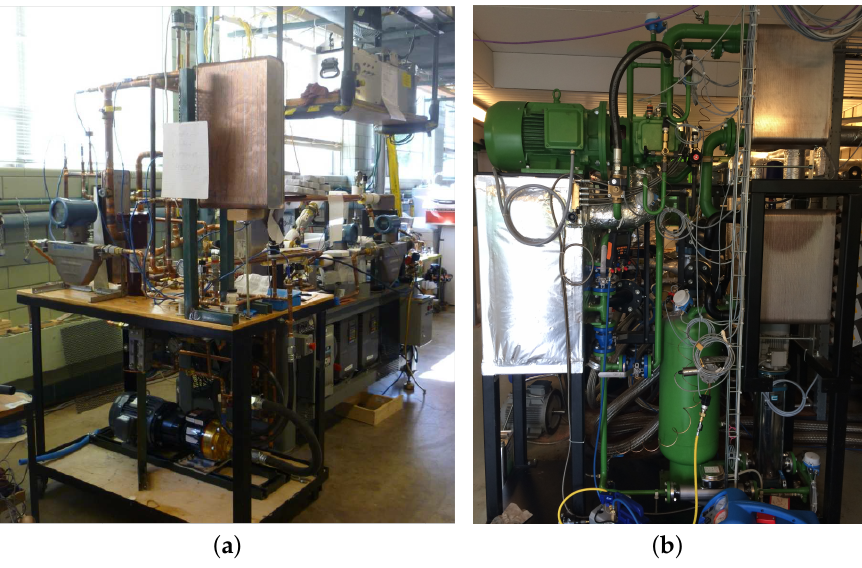
Figure 8. ( a ) Regenerative ORC with oil flooding loop at Ray W. Herrick Laboratories, Purdue University (PU); ( b ) regenerative ORC at Ghent University (UGent), Campus